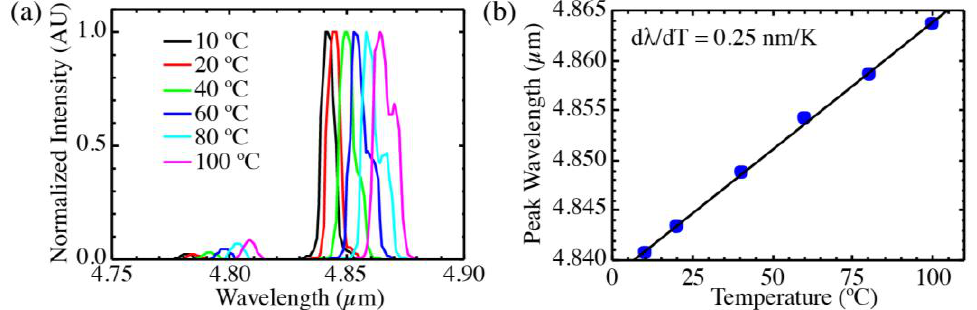
Figure 9. ( a ) Temperature-dependent emission spectra for the same laser of Design B whose temperature-dependent L-I characteristics are shown in Figure 8; ( b ) Peak wavelength as a function of temperature.